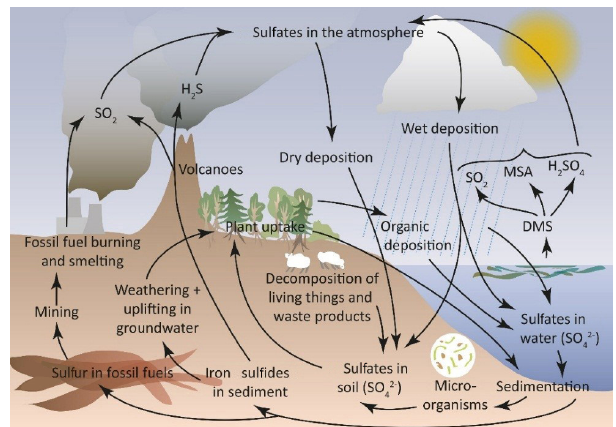
Figure 9. Schematic figure of the sulfur cycle.